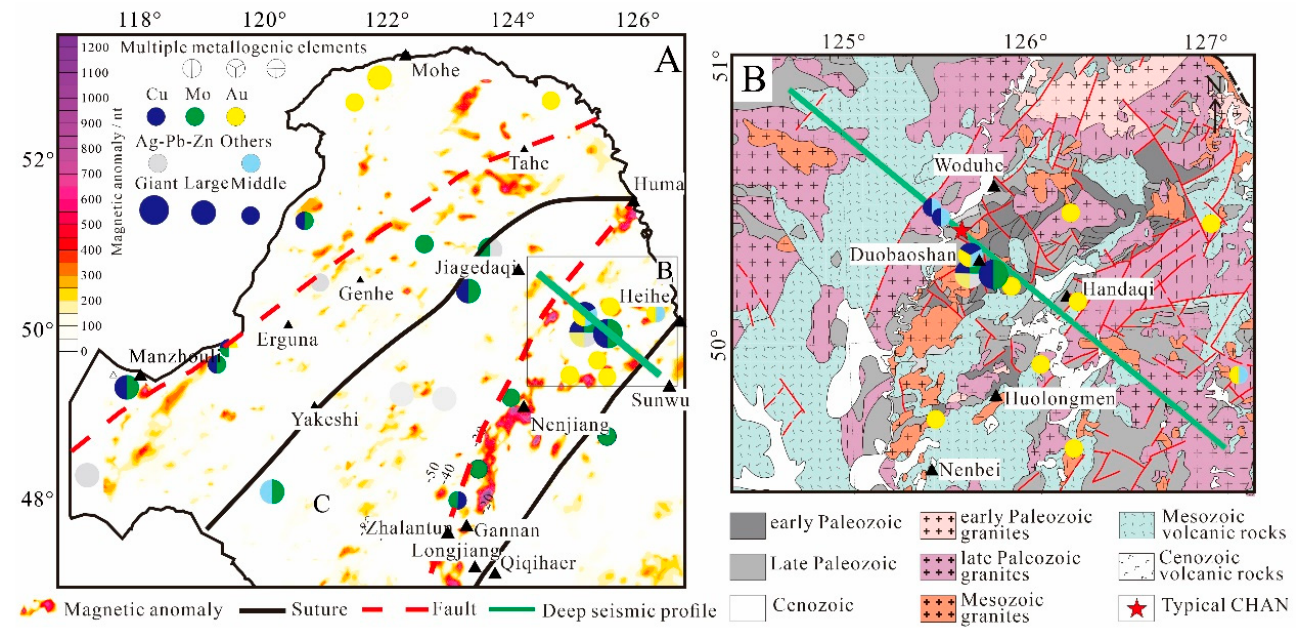
Figure 1. ( A ) Regional geophysical anomalies of the Duobaoshan ore district and adjacent regions.